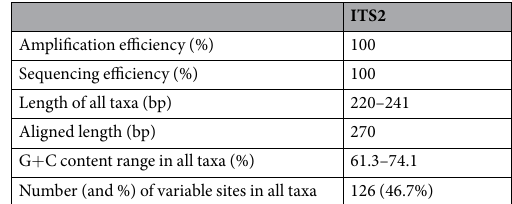
Table 1. Sequence information of samples.